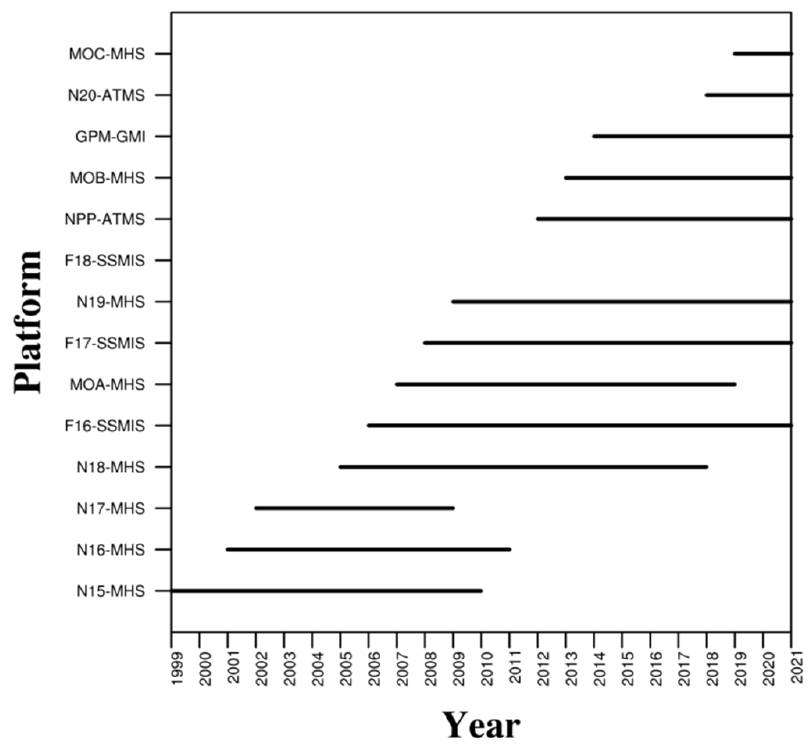
Figure 2. Operational satellite platforms between 1999 and 2021.